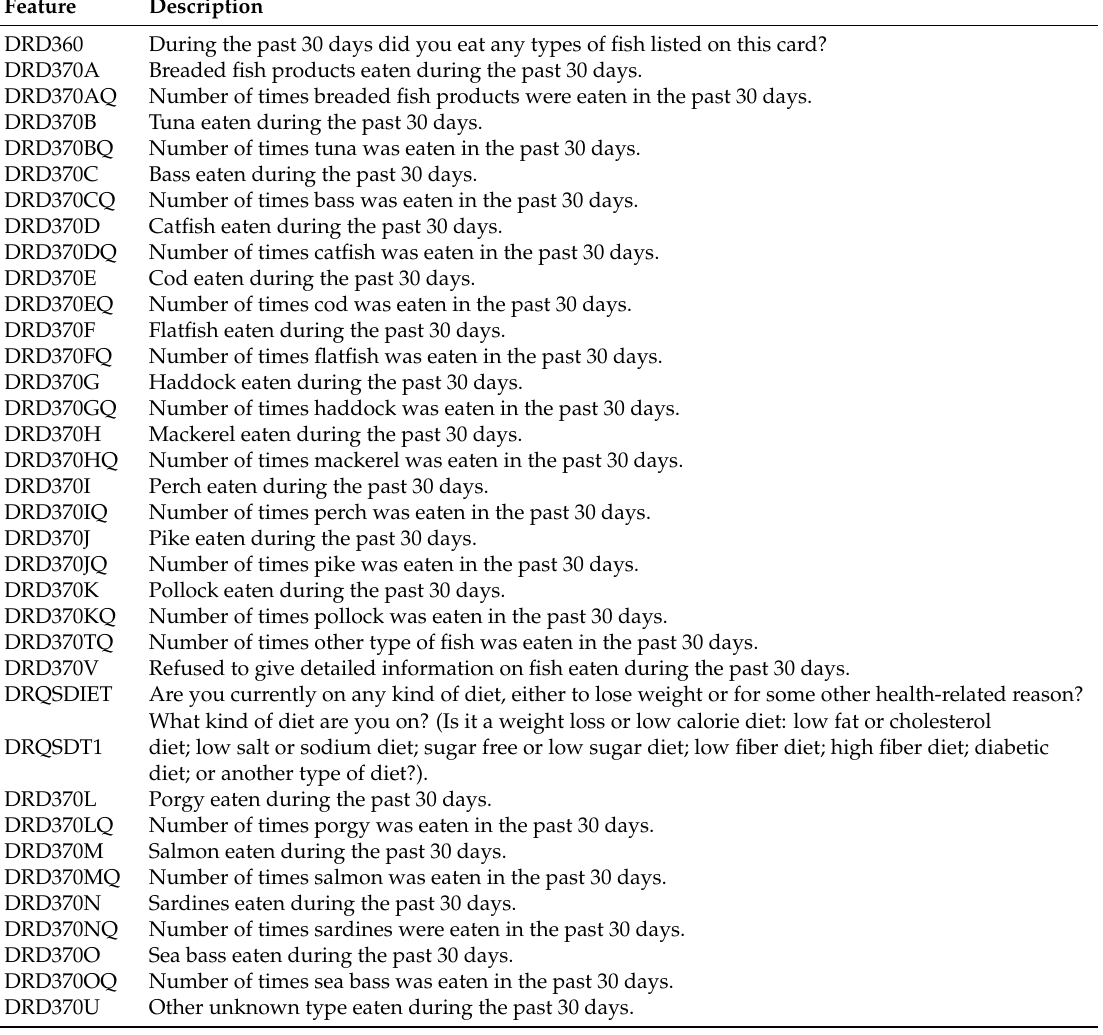
Table A5. Description of dietary